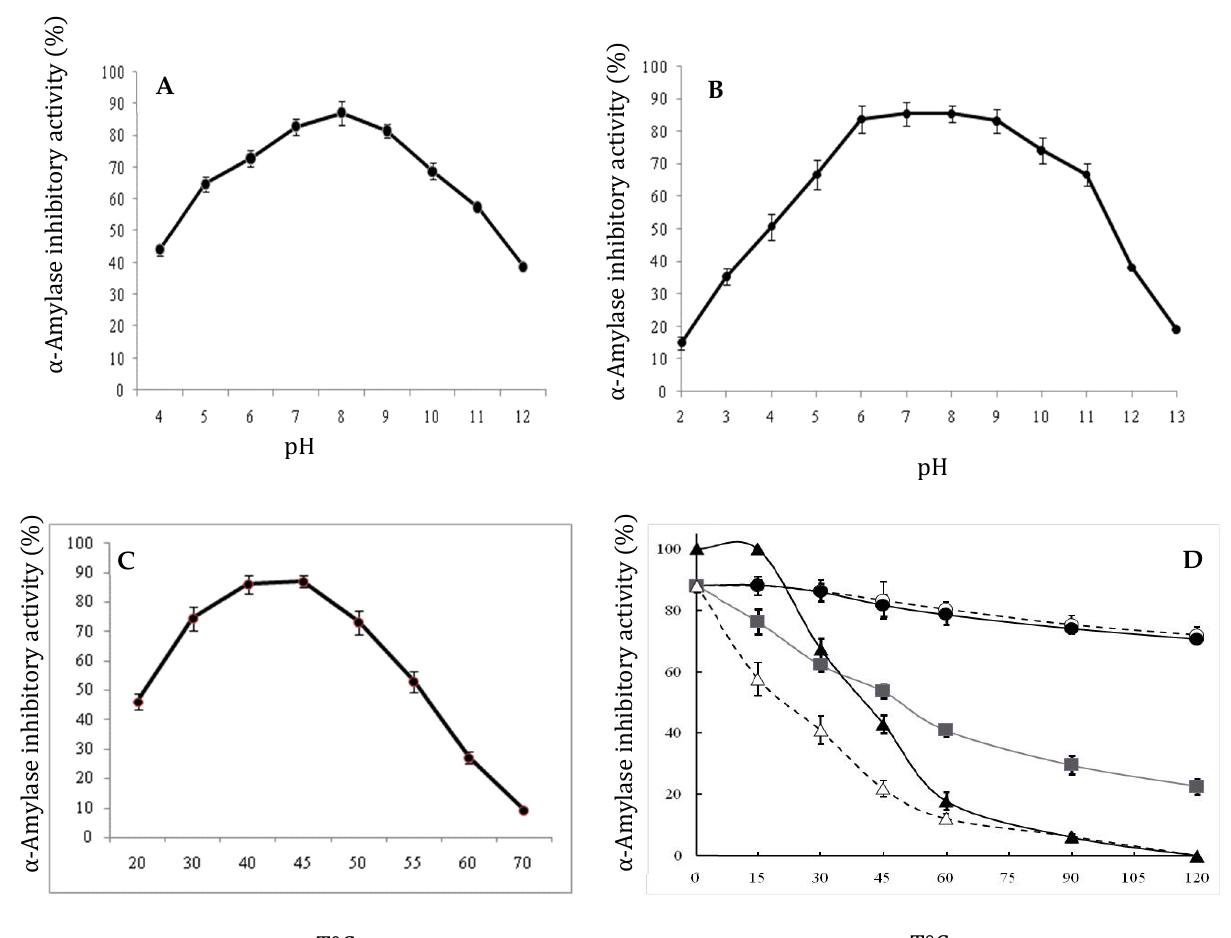
Figure 3. ( A , B ) Effect of pH and temperature on α AI.Mol activity: Effect of pH on PDInhibitor activity ( A ) and stability ( B ). Inhibitor activity was assayed at various pH levels, and inhibitor stability was tested after an incubation of the α AI.Mol at different pH levels for 12 h. ( C , D ) Effect of temperature on α AI.Mol activity ( C ) and stability ( D ). Inhibitor activity was assayed at various temperatures (50 °C–90 °C). For stability studies, the amylase inhibitor was incubated at different temperatures and drawn at various time intervals and assayed for residual inhibitor activity at optimal conditions of pH and temperature. Data shown are mean ± SD ( n = 3).